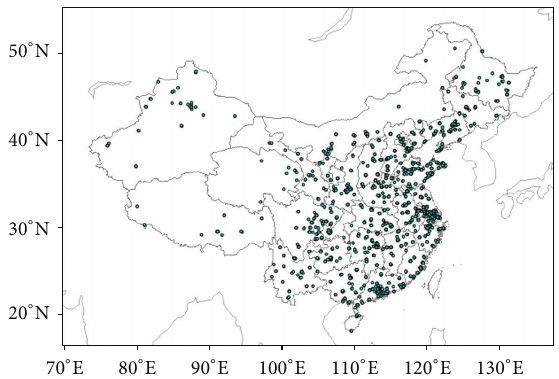
Figure 1: The air quality monitoring network of